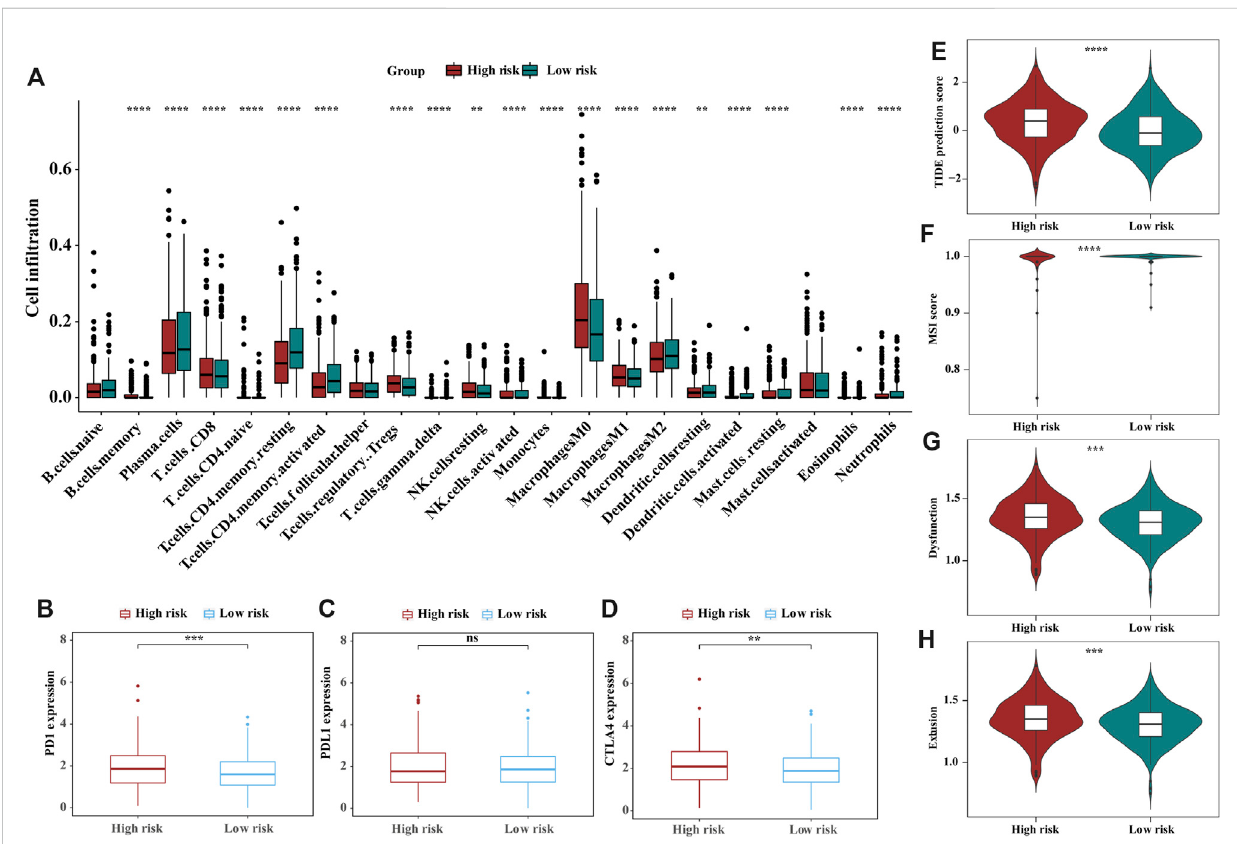
FIGURE 5 The landscape and estimation of the tumor immune microenvironment using the m6A-related gene signatures model. (A) The proportions of TME cells in different risk subgroups. Signi fi cant statistical differences between the two subgroups were assessed using the Wilcoxon test, the asterisks represented the statistical p -value (blank, not signi fi cant; * p < 0.05; ** p < 0.01; *** p < 0.001; **** p < 0.0001). (B – D) Expression of the immune checkpointsPD1 (B) ,PDL1 (C) andCTLA4 (D) betweenhigh-andlow-riskgroups. (E – H) TIDE (E) ,MSI (F) ,andT-cellexclusion (G) anddysfunction (H) score in the high- and low-risk patients. The scores between the two risk subgroups were compared through the Wilcoxon test (* p < 0.05; ** p < 0.01; *** p < 0.001; ns, not signi fi